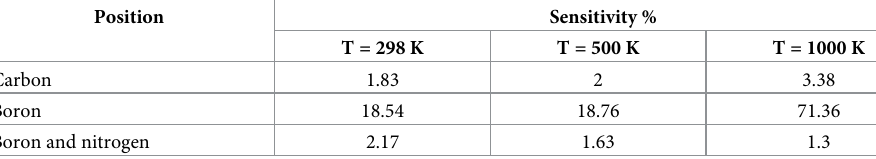
Table 3. Comparison of sensitivity for 12-BC 2 NNR at three different temperatures.